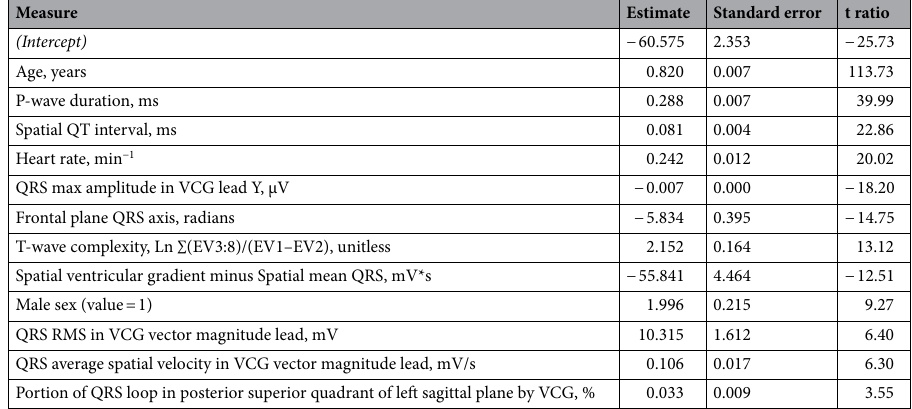
Table 3. Measures included in the 10-s ECG Heart Age for male subjects. Ln: Natural logarithm; EV: Eigenvalues; VCG: vectocardiographic; RMS: root mean square.